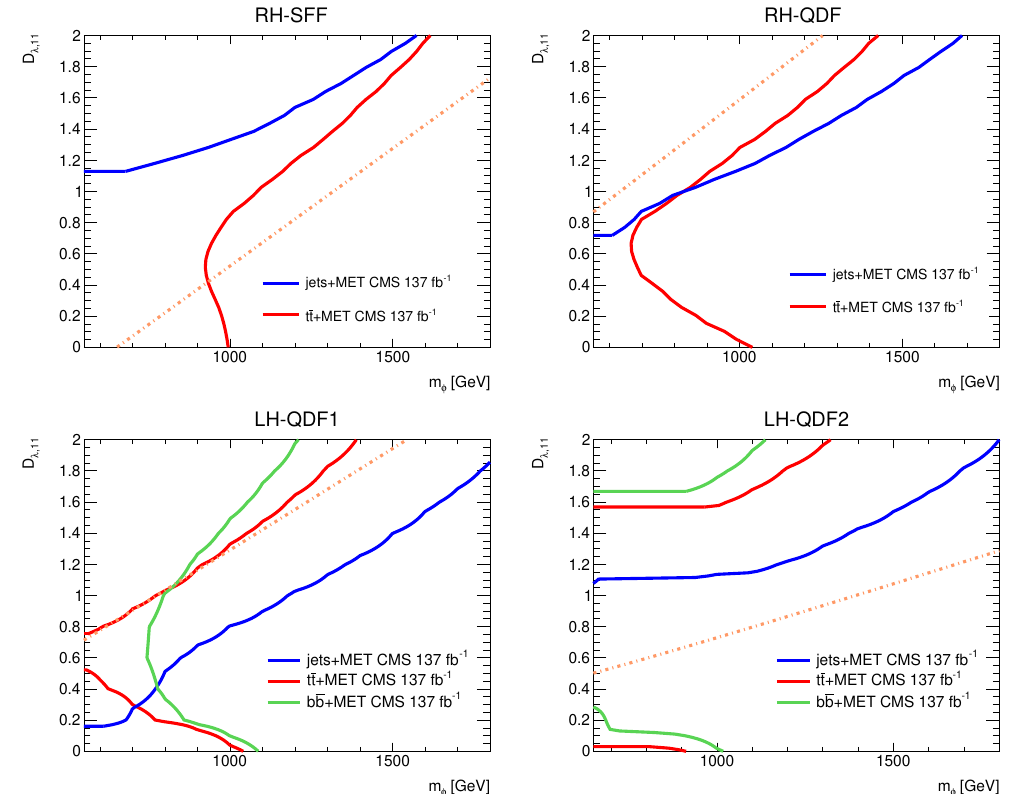
Figure 11 . Excluded areas in the ( m φ , D λ, 11 ) plane based on the analyses of the CMS collaboration on the full Run 2 statistics 13 TeV LHC data for the four benchmarks models proposed in this paper. The excluded areas are on the left of the curves. The orange dash-dotted lines indicate for which set of parameters the correct relic abundance is